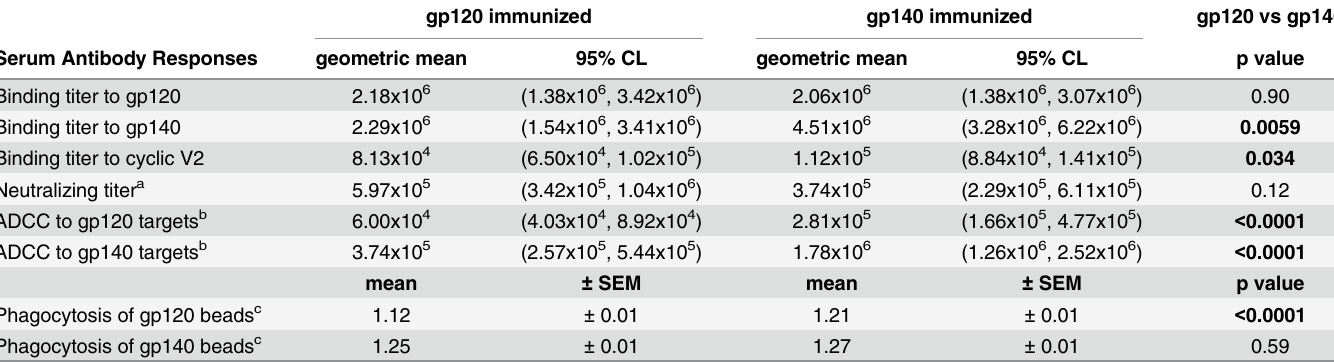
Table 1. Comparative immunogenicity of monomeric gp120 and oligomeric gp140: serum binding and functional antibody activities.